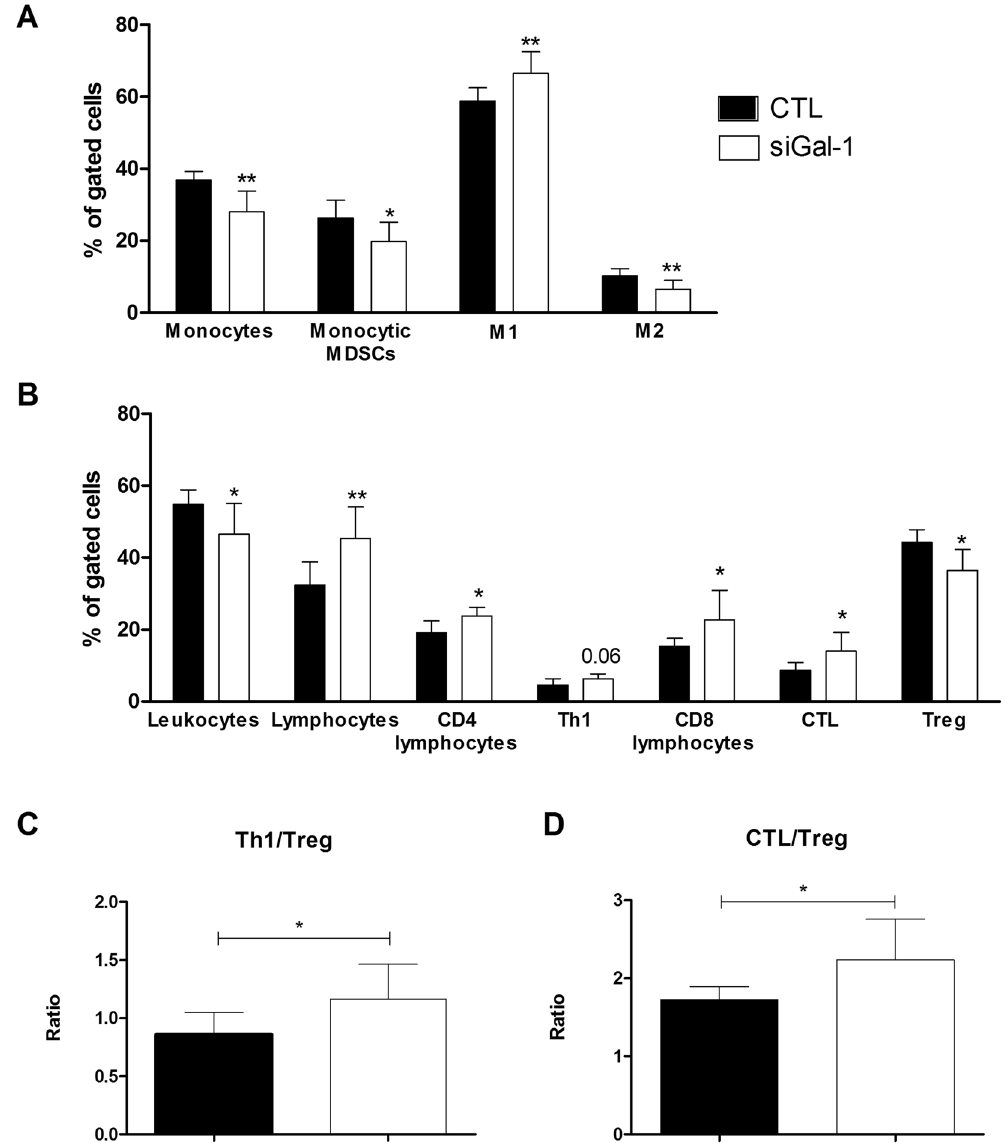
Figure 2. siGal-1 alleviates immune suppression and induces immune activation during GBM progression. Flow cytometry was performed on isolated mononuclear brain infiltrating cells of mice that were left untreated, or treated with siGal-1 on day 4, 8, 12 and 15 after tumor inoculation, and brains were isolated at day 20. Different stainings assess several cell populations with ( A ) the myeloid cells, with monocytes as gated by ZY − , CD45 + , CD11b + ; monocytic MDSCs as ZY − , CD45 + , CD11b + , Ly6C + ; M1 macrophage phenotype as CD45 + , CD11b + , ZY − , MRC − , MHCII high ; M2 macrophage phenotype as CD45 + , CD11b + , ZY − , MRC + , MHCII low . ( B ) The lymphoid cells with leukocytes, as single cells, ZY − , CD45 + ; lymphocytes as single cells, ZY − , CD45 + , CD3 + , CD4 lymphoctyes as single cells, ZY − , CD45 + , CD3 + , CD4 + ; Th1 as single cells, ZY − , CD45 + , CD3 + , CD4 + , IFN γ+ gated to CD45 + ; CD8 lymphocytes as single cells, ZY − , CD45 + , CD3 + , CD8 + ; CTL as single cells, ZY − , CD45 + , CD3 + , CD8 + , IFN γ+ gated to CD45; Tregs, as gated by single cells, ZY − , CD45 + , CD3 + , CD4 + , FoxP3 + ; ( C ) the ratio immune activation to immune suppression was calculated for Th1 (IFN γ+ CD4 + CD3 + CD45 + ZY − ) and ( D ) CTL (IFN γ+ CD8 + CD3 + CD45 + ZY − ), as compared to Treg (FoxP3 + CD4 + CD3 + CD45 + ). White bars represent the siGal-1 treated mice, black bars are control tumor bearing mice and groups were compared with unpaired t-test (n = 5/10 per group, * p < 0.05, ** p <